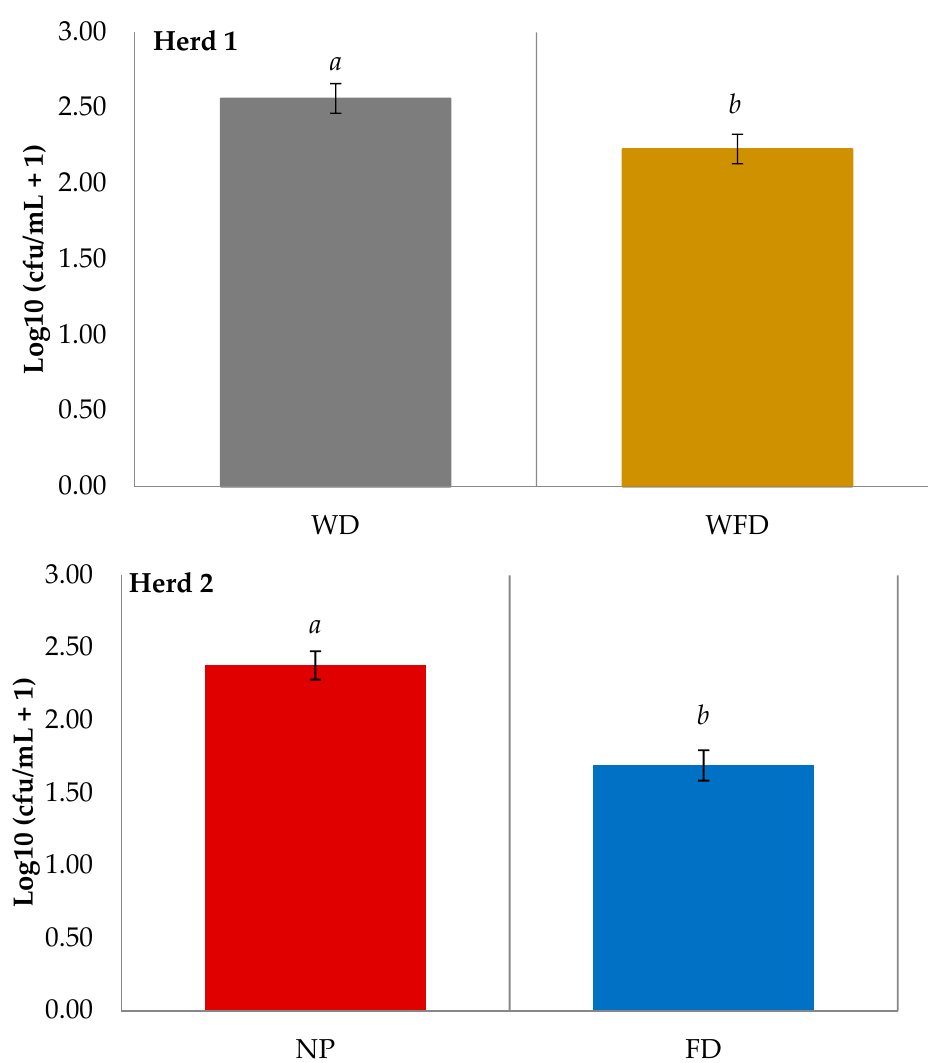
Figure 2. LS-means of the Log10 total bacterial count (TBC) on teat swabs after four different pre- milking teat preparation regimes across two dairy herds. (WD = wash with water and dry wipe, WFD = wash with water, foam application, and dry wipe, NP = no teat preparation, FD = foam application and dry wipe). ab Means with different letters differ significantly. Error bars indicate SEM.